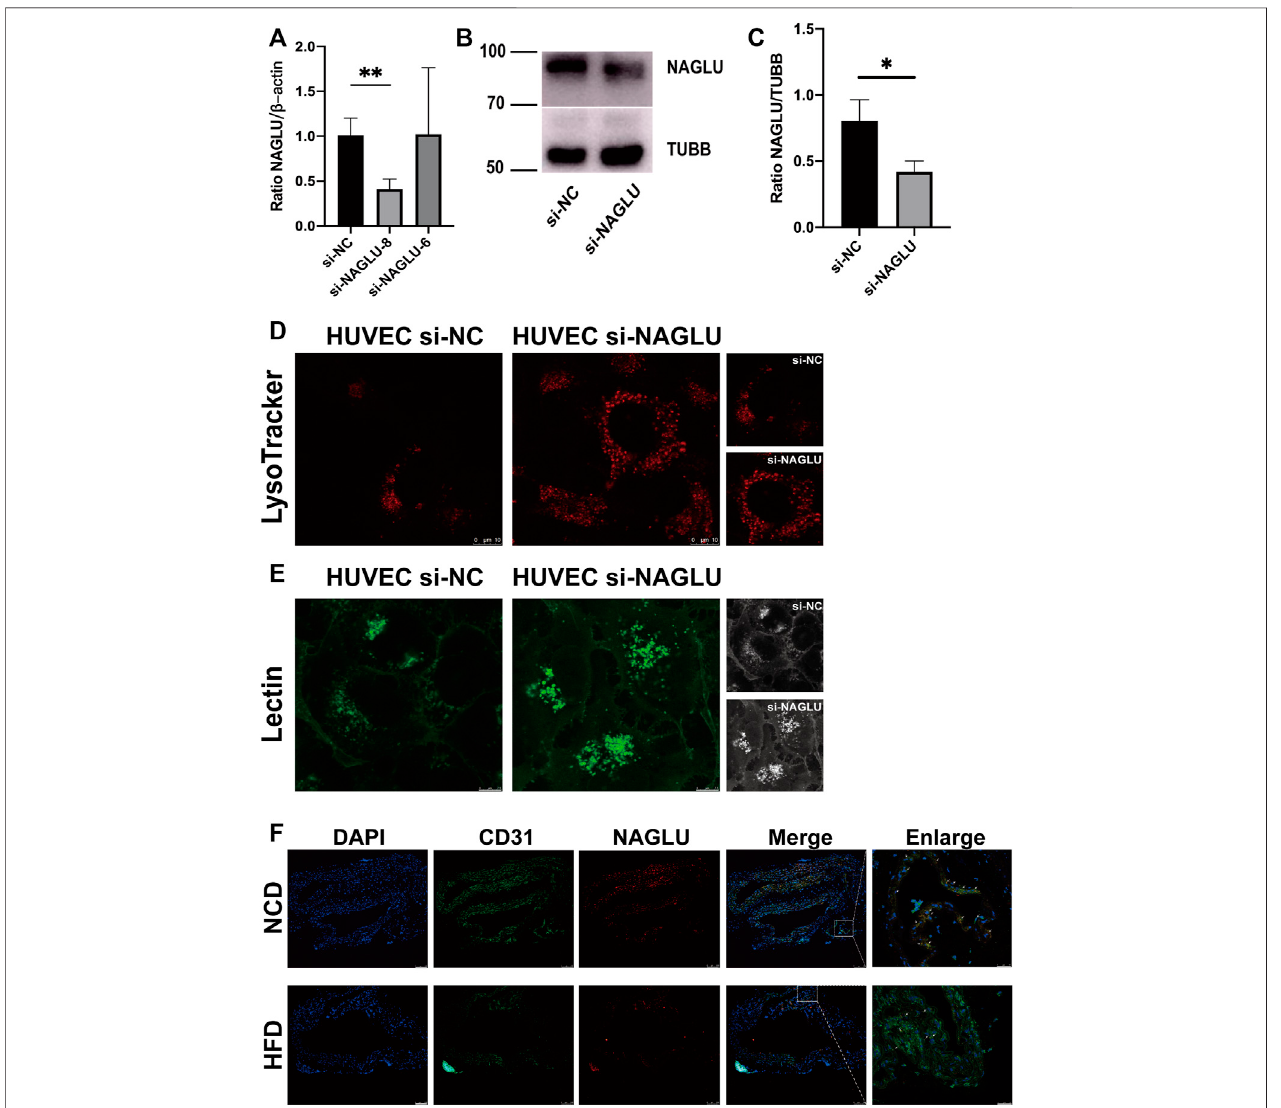
FIGURE4| NAGLUreductionintheEASanimalmodelandNAGLUknockdowninHUVECresultindefectivelysosomalstorage. (A) ThemRNAexpressionlevelsof NAGLU in HUVEC after transfection by qRT-PCR. si-NAGLU-8 was used for subsequent research. (B,C) The protein expression levels of NAGLU in HUVEC after transfection with si-NAGLU and si-NC as measured by Western blotting; TUBB was used as a control. (D) Representative images of lysosomes labeled with the LysoTrackerprobeinHUVECsi-NAGLUandHUVECsi-NC.Scalebars:10 μ m. (E) RepresentativeimagesofHSlabeledwithlectinprobeinHUVECsi-NAGLUand HUVECsi-NC.Scalebar:7.5 μ m. (F) Representativeimagesof ApoE − / − miceaorticarchesstainedwithDAPI,NAGLU,andCD31.NCD:normalchowdiet;HFD:high-fat diet. * p < 0.05, ** p < 0.01, Student ’ s t-test.